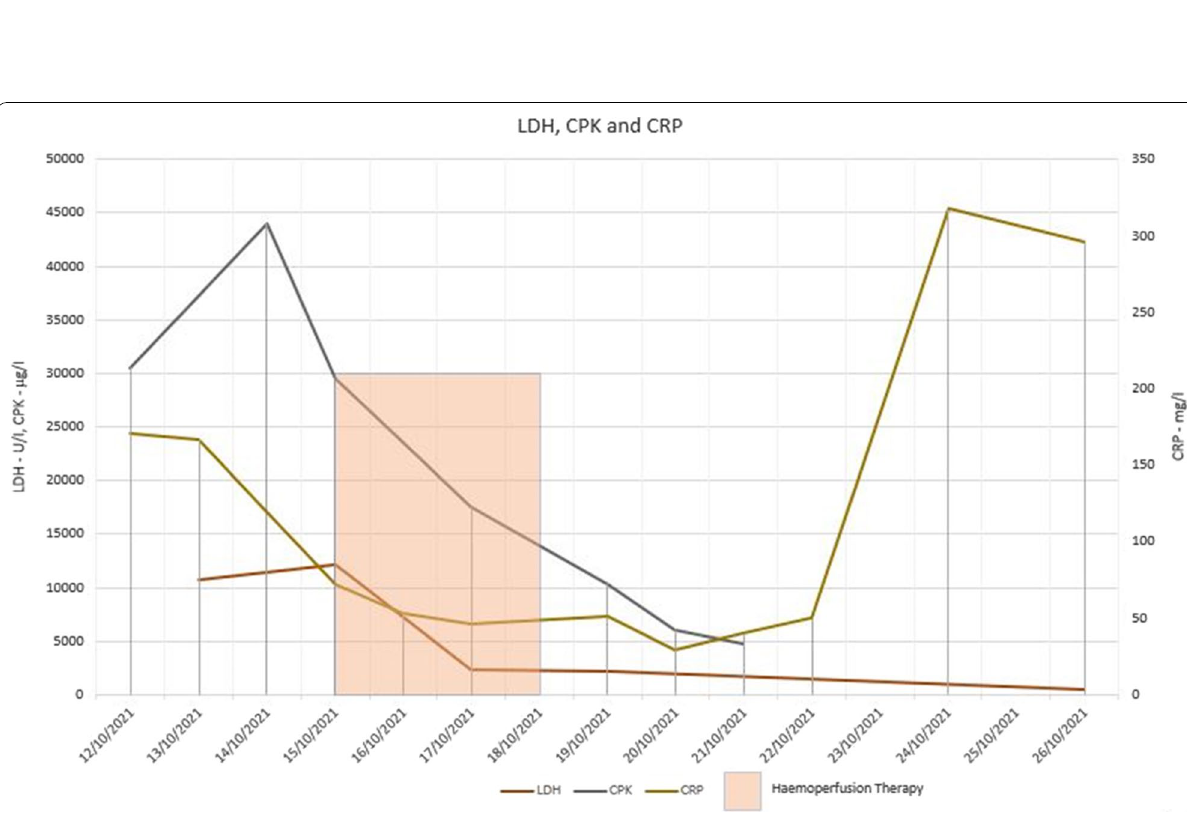
Fig. 6 Progression of LDH, CPK, and CRP during the ICU stay. The transaminase levels dropped progressively, but the bilirubin levels were rising. Thrombocytopenia and haemolysis persisted even after the coagulopathy was